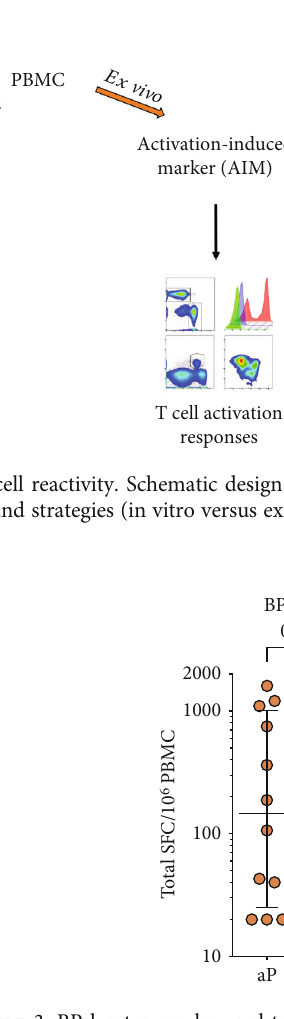
Figure 3: BP lysates can be used to expand cells for assessing BP antigen reactivity. The magnitude of responses expressed by spot- forming cells (SFC) is shown for the sum of T cell responses (IFN γ , IL-5, IL-17, and IL-9) for lysate restimulation after 14 days of expansion with BP lysate ( n = 12 for aP and n = 12 for wP cohorts). Data are expressed as median ± interquartilerange for each cohort with the Mann – Whitney U test comparison